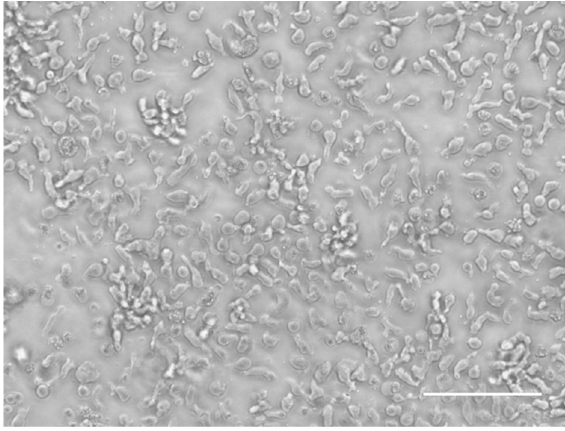
Figure 1. Morphology of in vitro generated T-lymphoblasts. Scale bar = 100 µ